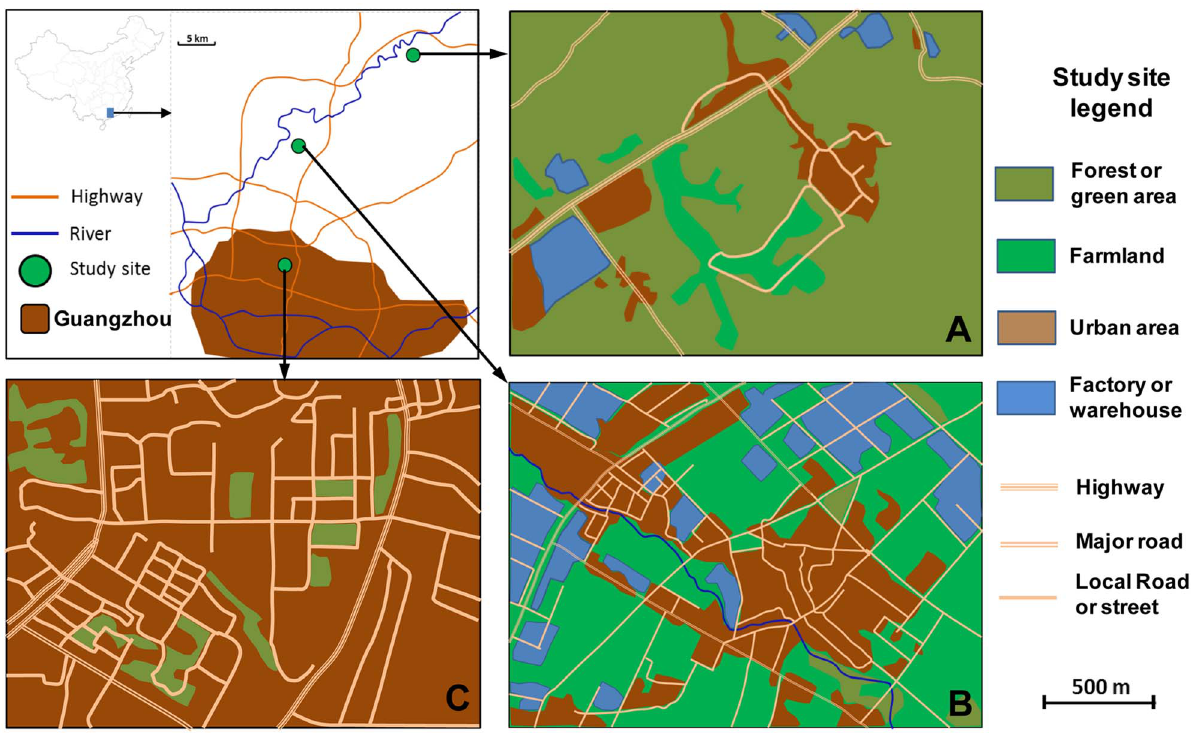
Figure 1. Map of study areas in Guangzhou, Guangdong province, China. The ecology study of Aedes albopictus was conducted in three areas. A: Rural, Dengcun in Conghua county, B: Suburban, Liangtian, in Baiyun district, C: Urban, Tonghe in Baiyun district.